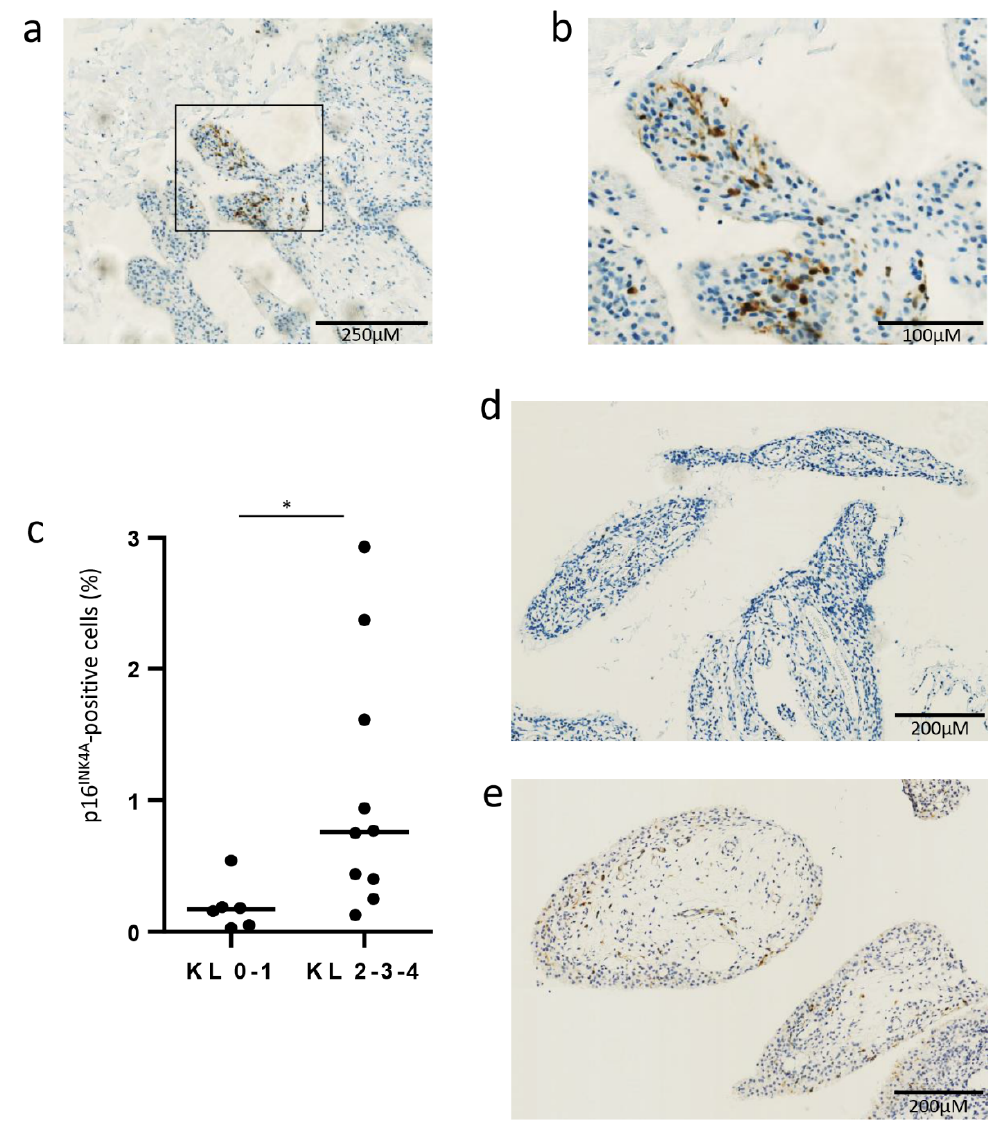
Figure 1. Senescent p16 INK4A -positive cells in OA synovial membrane taken from a biopsy. ( a , b ) Representative pictures in a positive area of p16 INK4A staining in OA synovial membrane from a biopsy at magnification 4 and 10, respectively. ( c ) Number of p16 INK4A -positive cells between patients with Kellgren and Lawrence grade 0 and 1 (KL0-1, n = 6) and patients with Kellgren and Lawrence grade 2, 3 and 4 (KL2-3-4, n = 10) (median). ( d , e ) Representative picture of p16 INK4A staining in OA synovial membrane from a patient with KL 0-1 ( d ) and from a patient with KL 2-3-4 ( e ). * p <